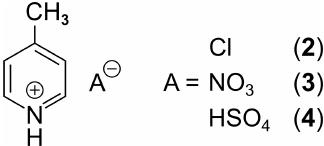
Figure 3. γ -picoline derivatives ( 2 – 4